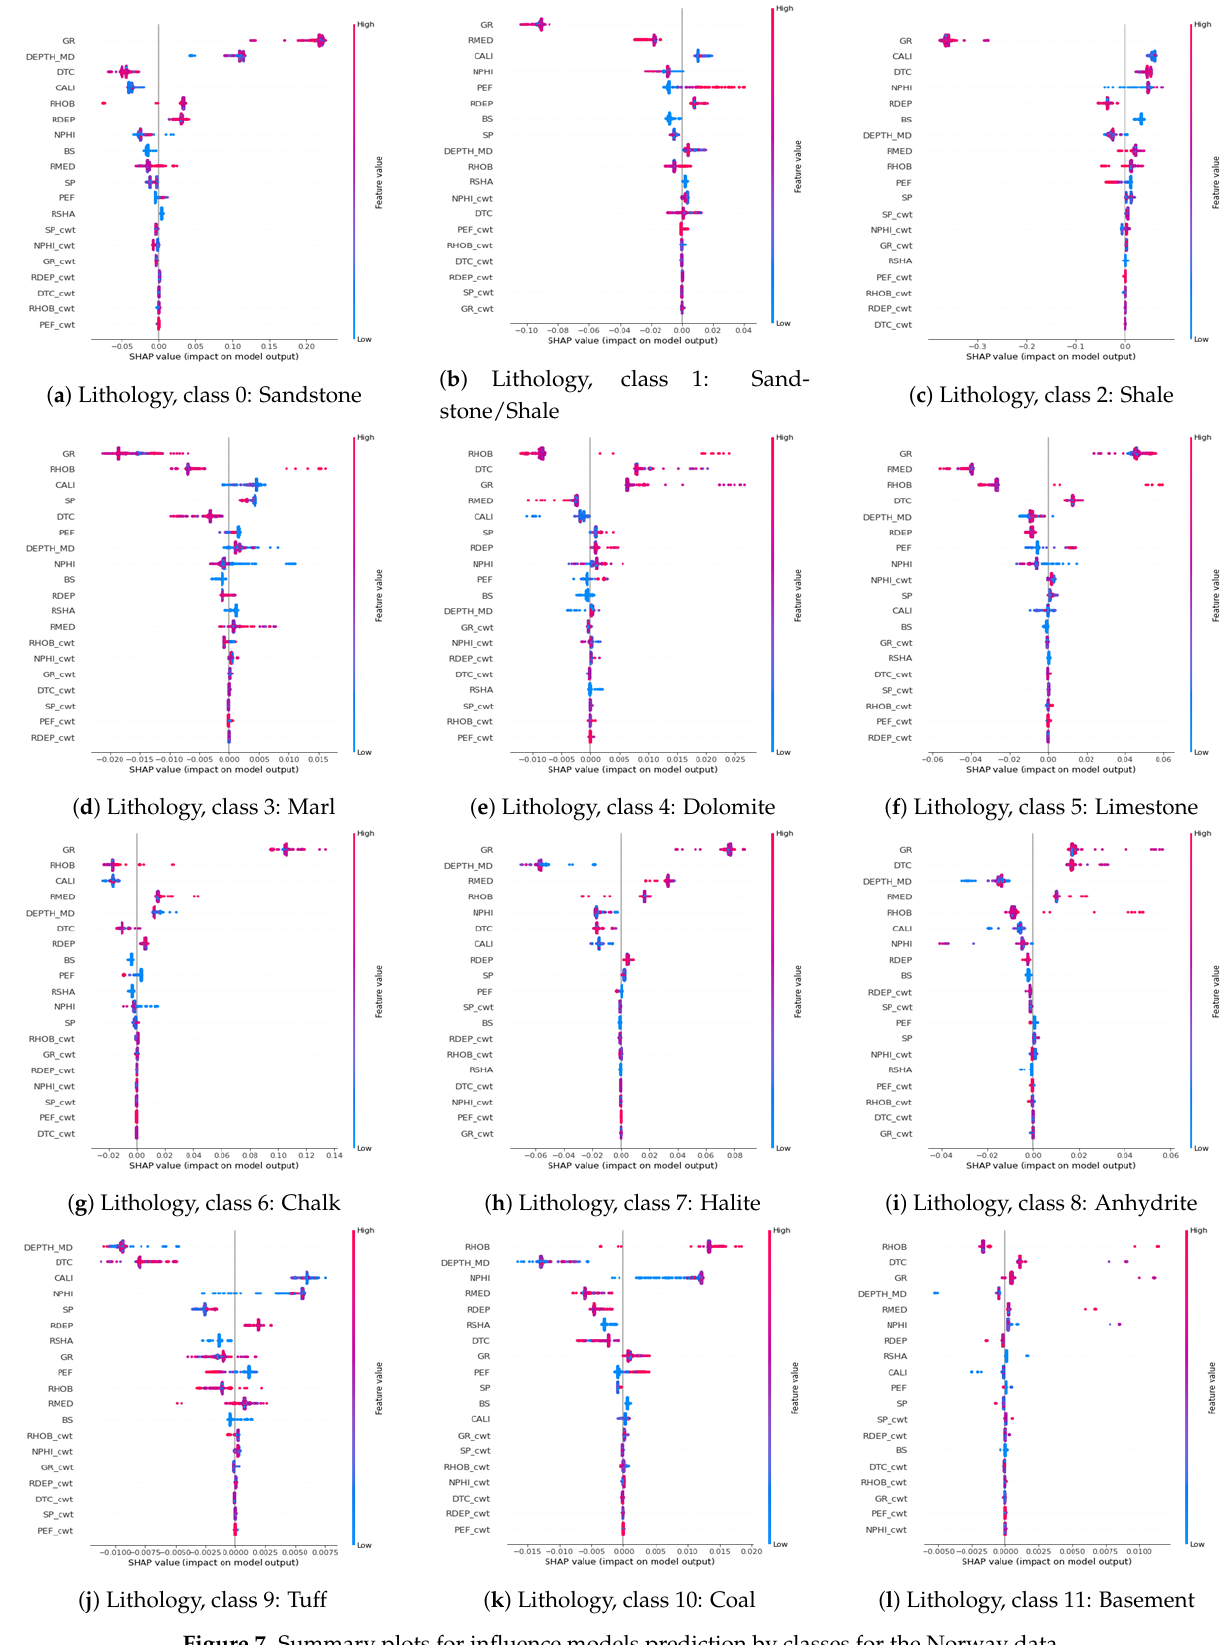
Figure 7. Summary plots for influence models prediction by classes for the Norway